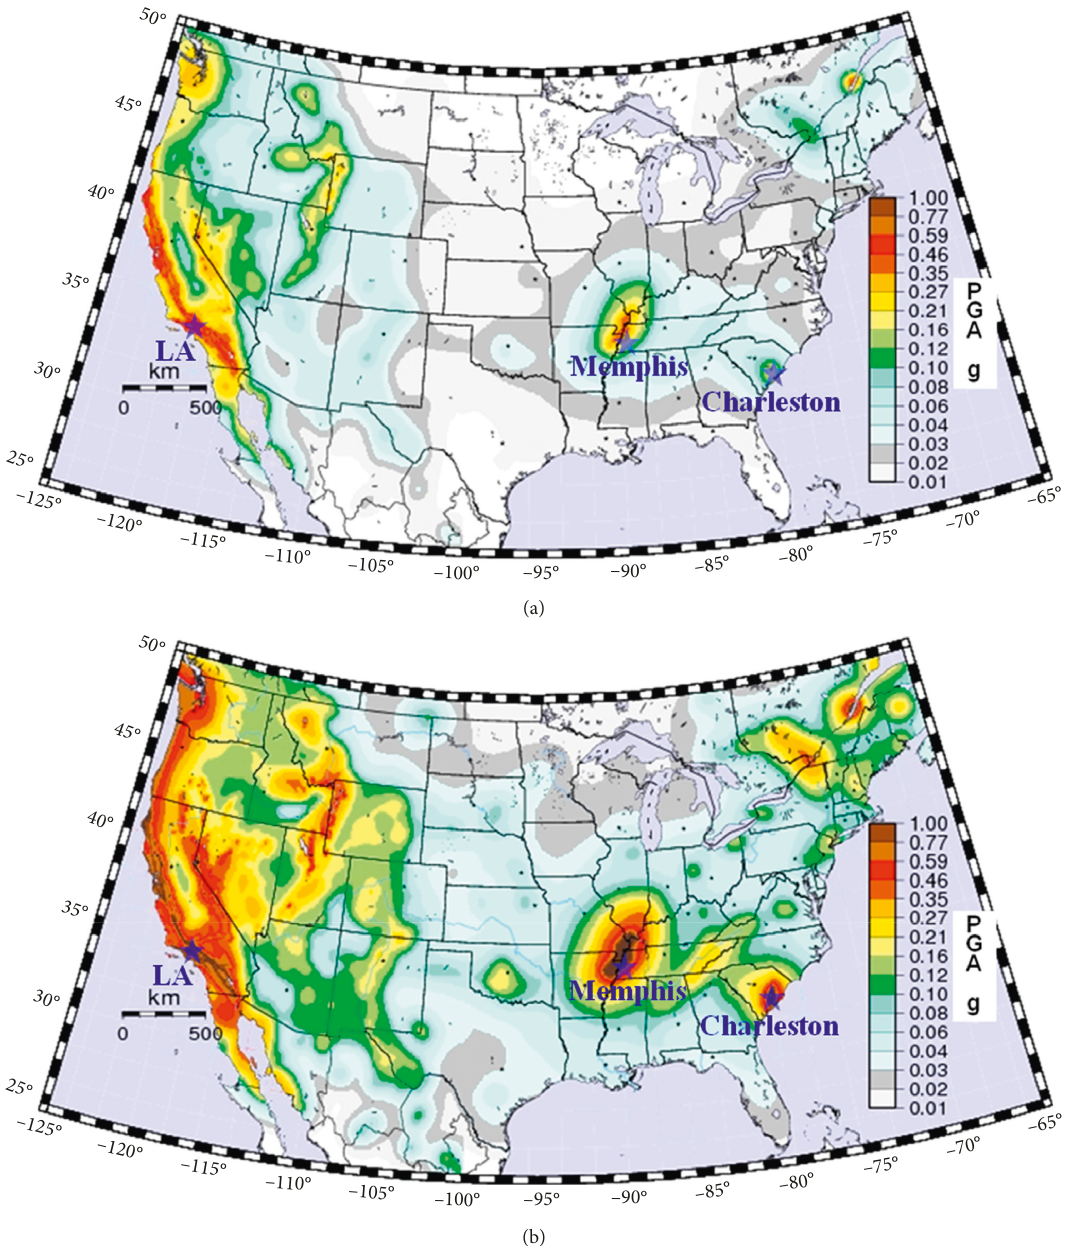
Figure 14: Seismic hazard maps for the US [58]: (a) 10% probability of exceedance in 50 years map of PGA; (b) 2% probability of exceedance in 50 years map of